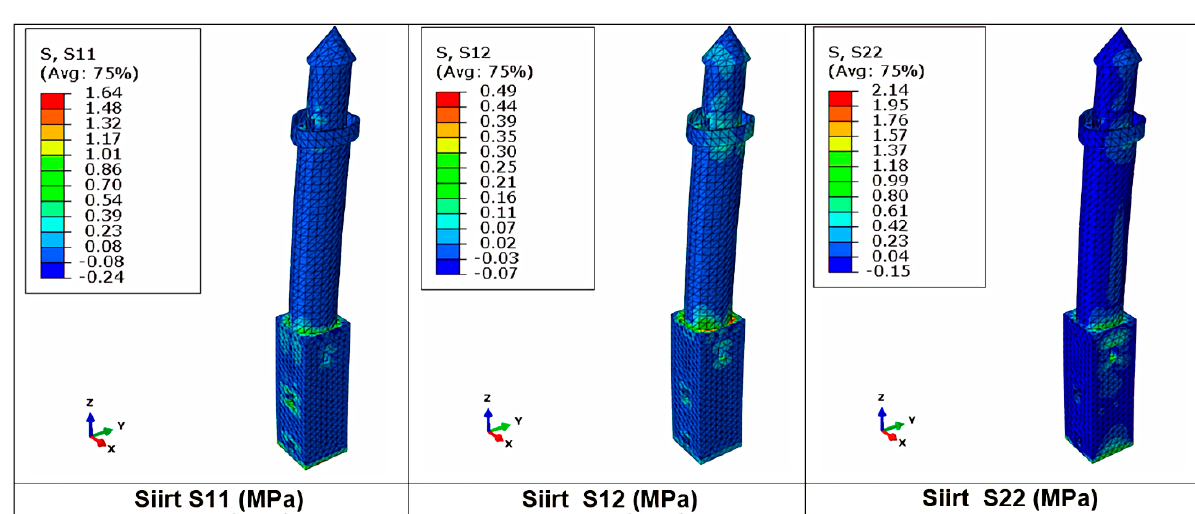
Figure 29. Stresses for the province of Siirt (Center).